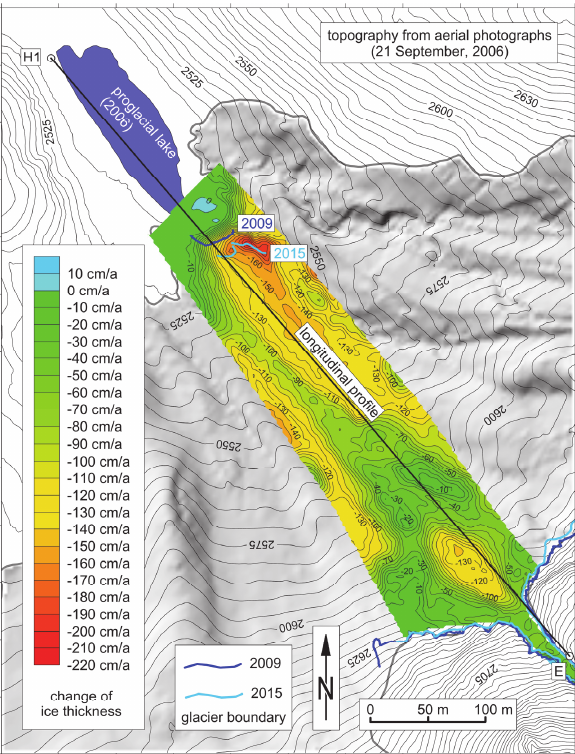
Figure 5. Change in ice thickness along the longitudinal profile of Gössnitzkees for the time period 1988-1997-2009-2012- 2015.